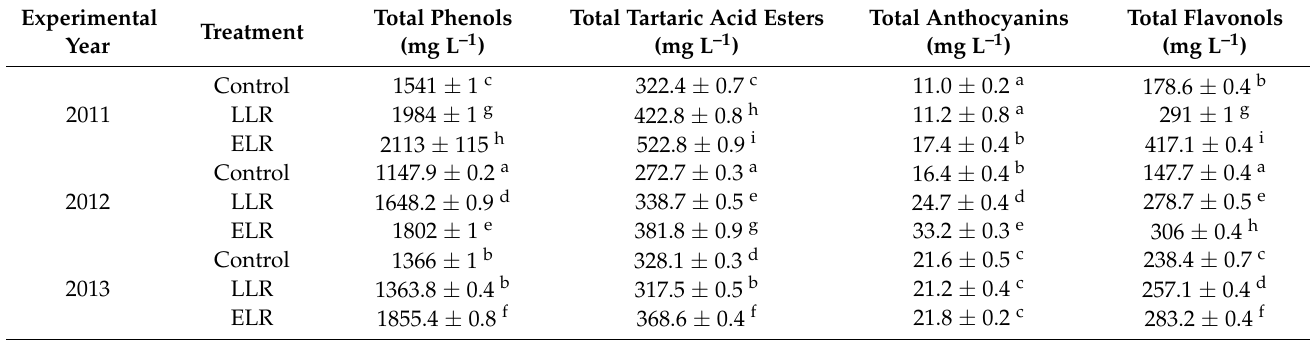
Table 4. Effects of leaf removal time and experimental year on the concentrations of total phenols, tartaric acid esters, and anthocyanins and flavanols in wine (after 6 months of aging) determined by HPLC. LLR, late leaf removal; ELR, early leaf removal. Data are means of three replicates ± sd. Different letters in a column denote significant differences among treatments according to Tukey’s test following a two-way ANOVA at α =